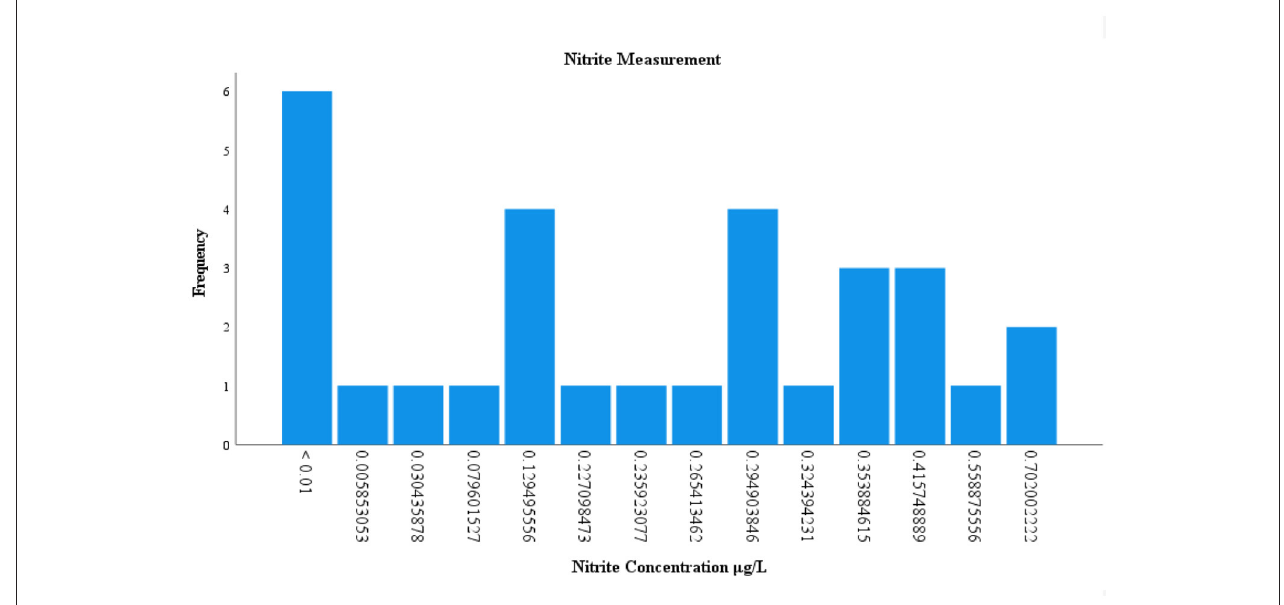
FIGURE 4 | Measurement of nitrite in Lake Manatee.